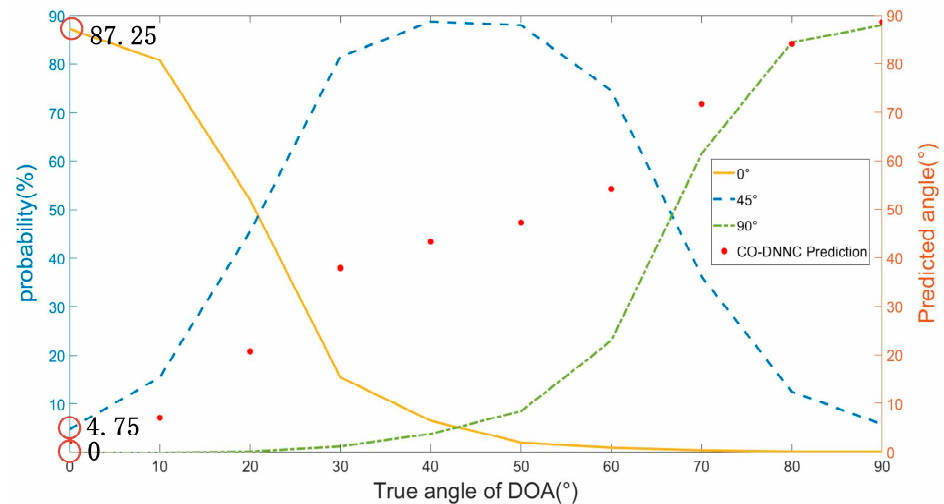
Figure 3. Probabilities of Softmax in DNNC and predicted azimuth by CO-DNNC.